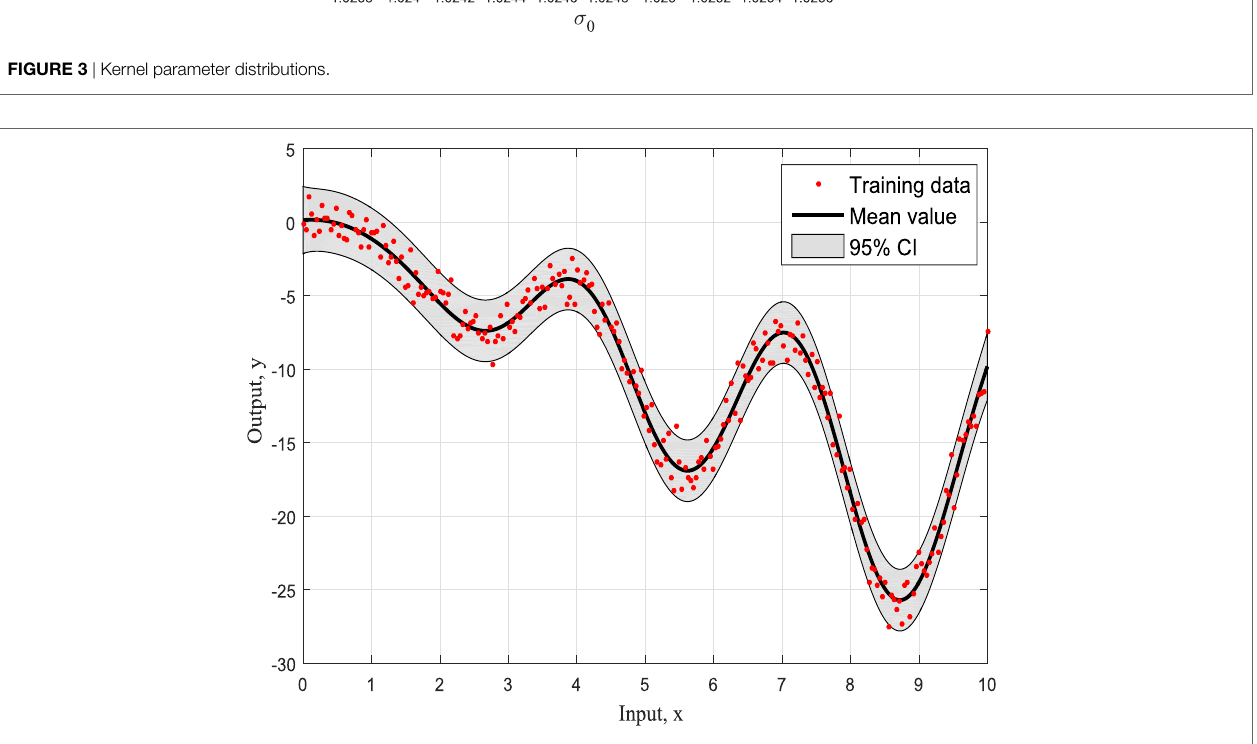
FIGURE 4 | Model 1,